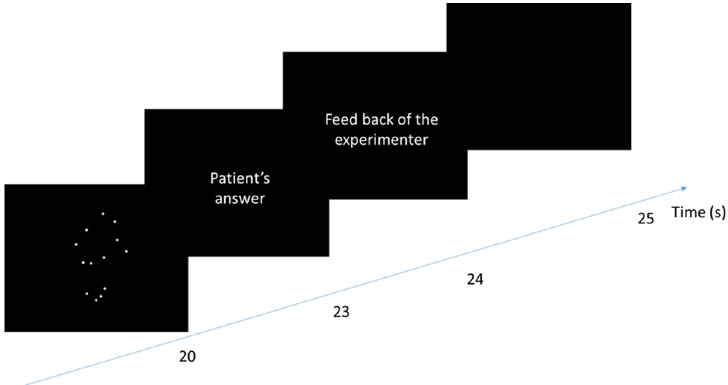
Figure 1. Time course of a trial of observation task for the experimental group. The patients saw on a loop (over 20 s) a PLD representing a lower human action. After that, they had 3 s to name the perceived action. When the response was correct, the experimenter said, “it is correct”, and when it was false, the experimenter gave the correct answer. The next trial started after 1 s.